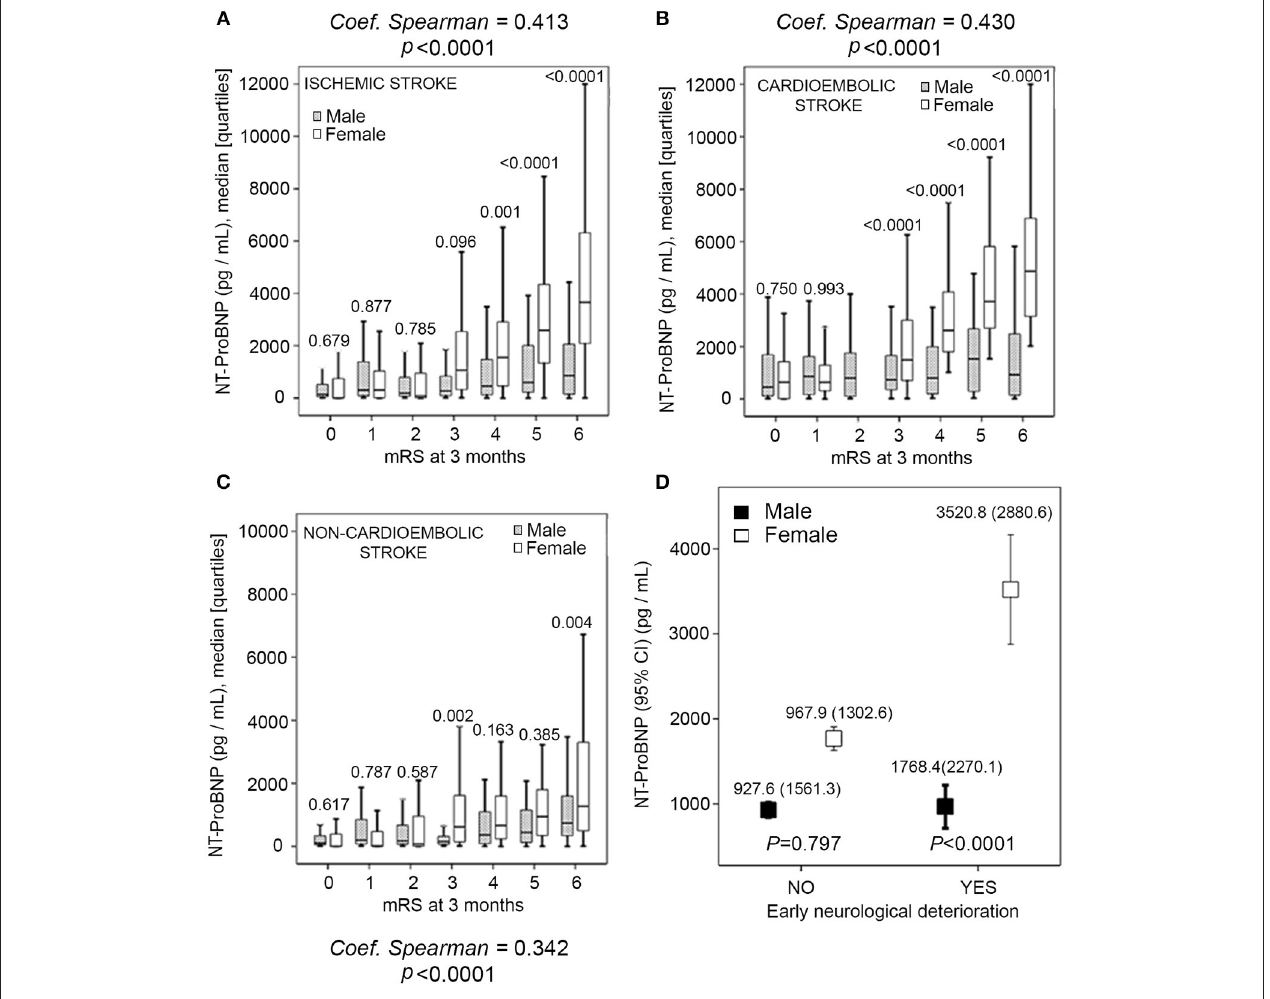
FIGURE 2 | (A–C) Sex correlations between pro-brain natriuretic peptide (NT-proBNP) serum levels and 3-months modified Rankin Scale (mRS) score after stroke in all patients, cardioembolic and non-cardioembolic stroke patients. (D) Sex-related difference in NT-proBNP levels with and without early neurological deterioration